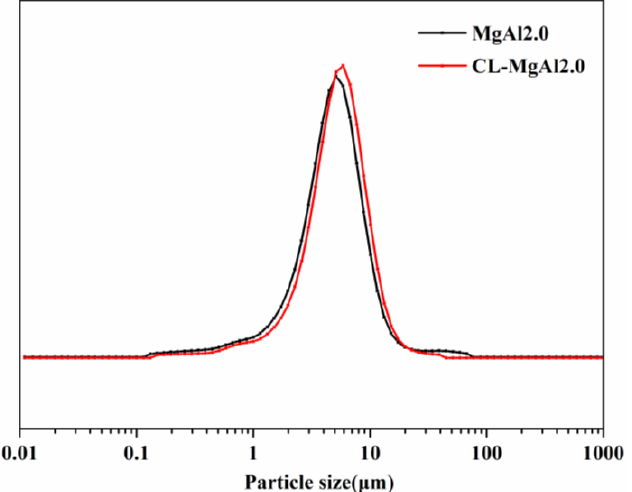
Figure 11. Particle size distribution (dry method) of MgAl2.0 and its crosslinked counterpart CL- MgAl2.0.